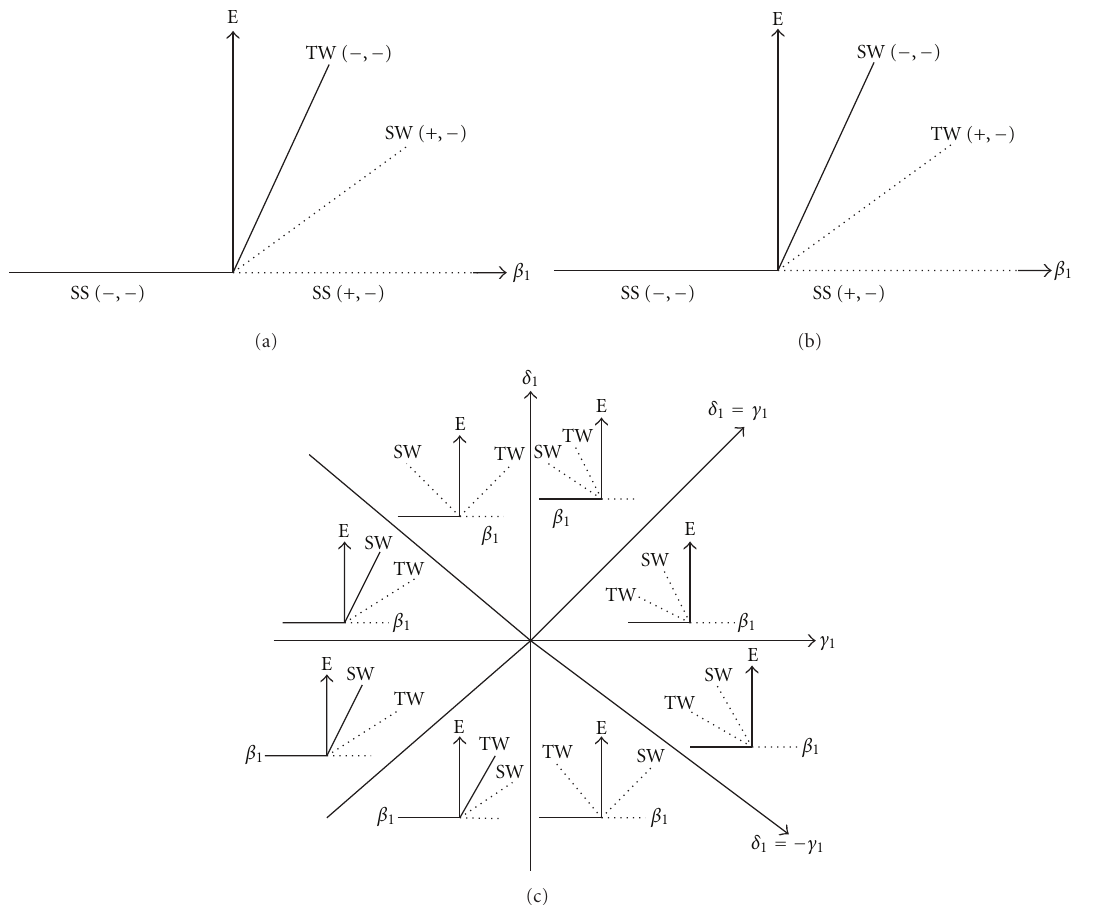
Figure 6: (a, b, c) are typical diagrams showing the stability of equilibrium solutions SS (steady state), SW (standing waves), and TW (travelling waves). On solid lines equilibrium solutions are stable and on dotted lines they are